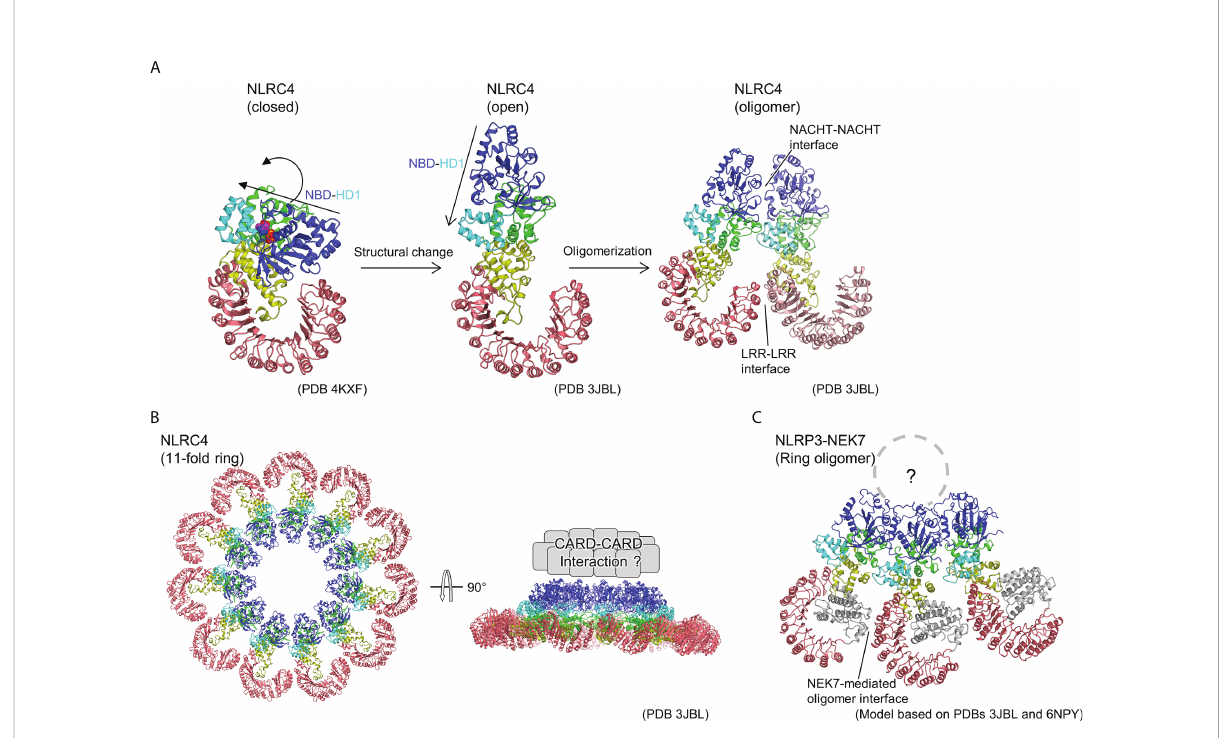
FIGURE 2 Ring-shaped active oligomer of NLRC4. (A) Structural changes underlying NLRC4 oligomerization. The NLRC4 monomer undergoes a structural change from a closed (PDB 4KXF) (16) to an open form (PDB 3JBL) (17), causing the NBD-HD1 part to undergo a large rotational movement relative to the other parts. This opens the NACHT domain and the corresponding activated NLRC4 molecules to form a laterally aligned dimer and subsequently form ring-shaped oligomer. (B) Structure of 11-fold ring-shaped NLRC4 oligomer (PDB 3JBL) (17). Top (left) and side (right) views are shown. The CARD domains are predicted to be concentrated at the top of the ring as shown schematically in the side view (right). (C) Hypothetical structure of NLR3-NEK7 oligomer. The structure of the inactive form of the NLRP3-NEK7 complex (6NPY) (36) was split into the NBD-HD1 and the WHD-HD2-LRR parts, and each was fi tted into the corresponding part of the 11-fold ring oligomer of NLRC4 (PDB 3JBL)